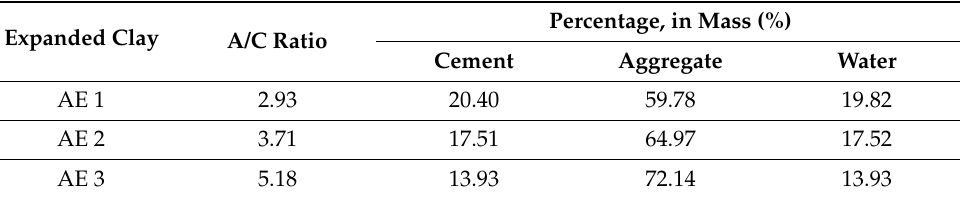
Figure 3. Porous concrete test specimens with expanded clay, prepared for impedance tube meas- urements. Table 1. Aggregate/Cement ratio of the porous concrete mixtures.